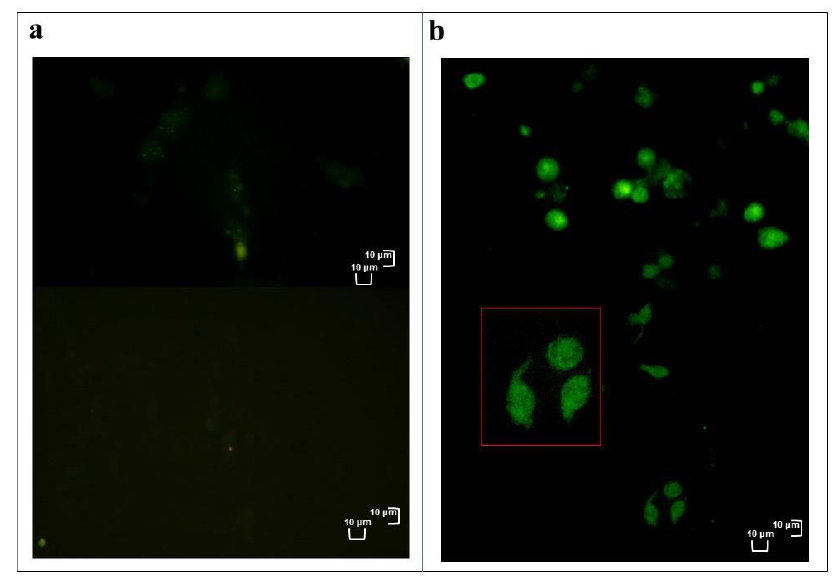
Figure 4. Healthy in vitro haemocytes ( a ) or treated with OPs for 2 h ( b ) and stained with 2,7 di- chlorodihydrofluorescein acetate (H 2 DCFDA). Red box = enlargement of cells below. Scale bar 10 μm.